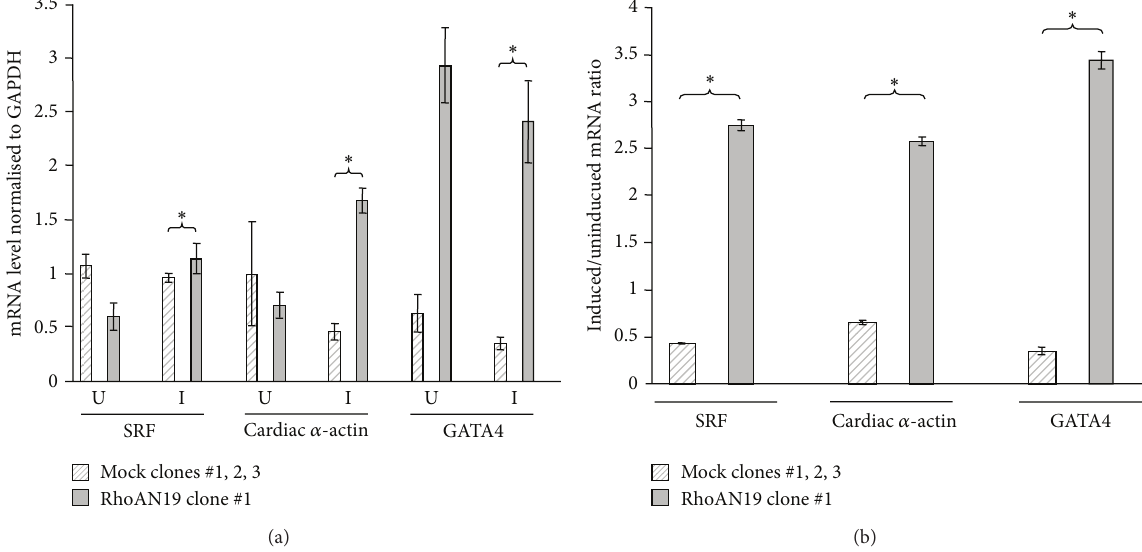
Figure 5: mRNA levels of selected genes involved in heart development in noninduced and induced P19CL6 cells. RNA was extracted from the different P19CL6 cell lines after growth in GM (uninduced, U) and DM (induced, I) for 14 days, then subjected to qPCR. The mRNA expression levels were normalised to GAPDH. Values for mock transfected (Mock) clones #1, 2, 3 represent combined results for these three cell lines. Values represent the mean ± SEM of three to six independent experiments. ∗ 𝑃 < 0.05 , compared to mock transfected cell